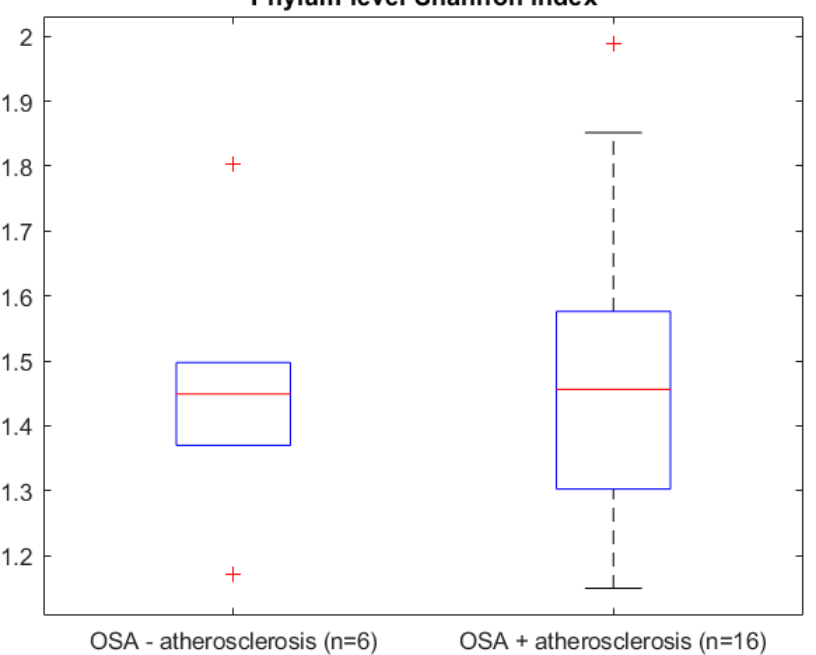
Figure 2. Wilcoxon rank sum test between the phylum level Shannon indexes of the groups.